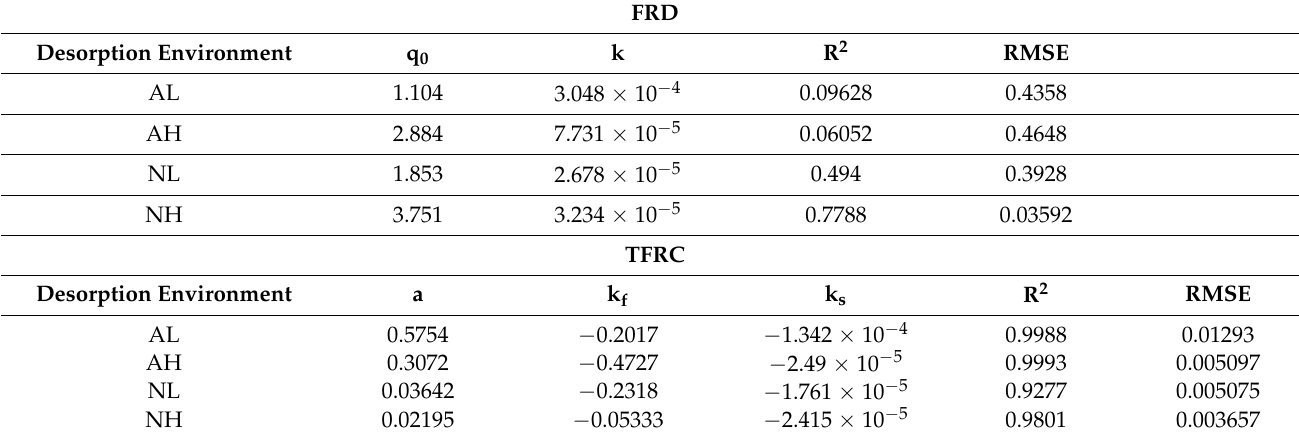
Table 7. Desorption two term exponential model fitting parameters.